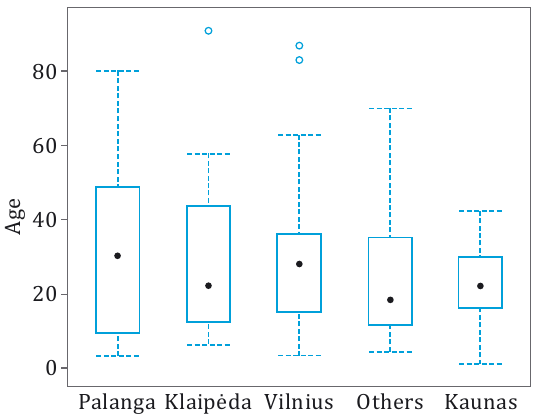
Figure 1. Age distribution of injuries in e-scooter-involved accidents Palanga Klaipėda Vilnius Others Kaunas by city in 2019–2020